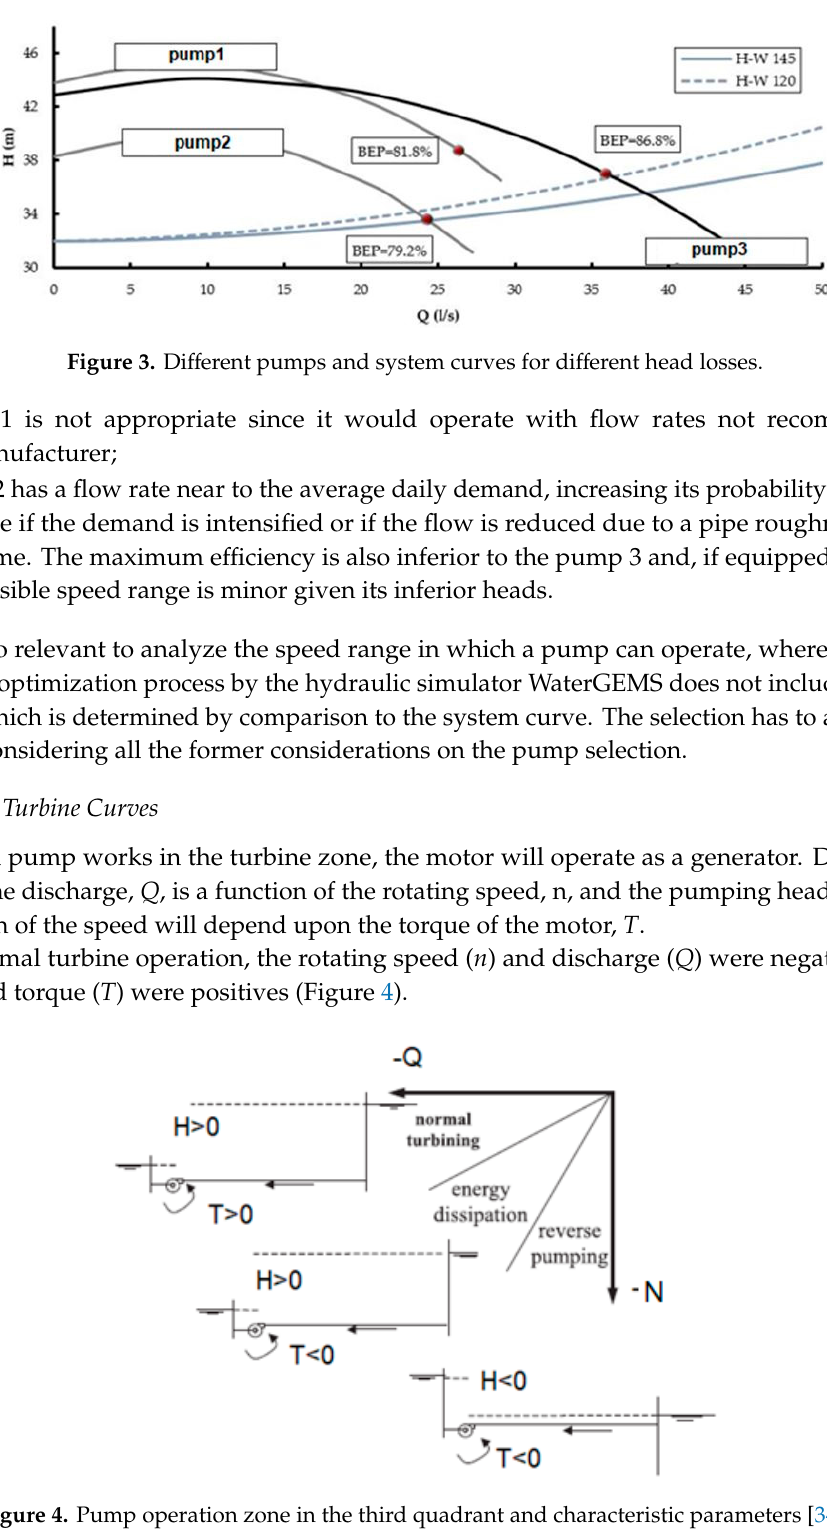
Figure 4. Pump operation zone in the third quadrant and characteristic parameters [34].